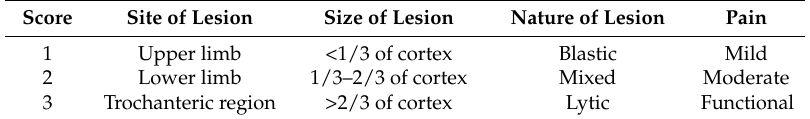
Table 2. Mirels’ scoring system for diagnosing impending pathologic fractures in a long bone [59].